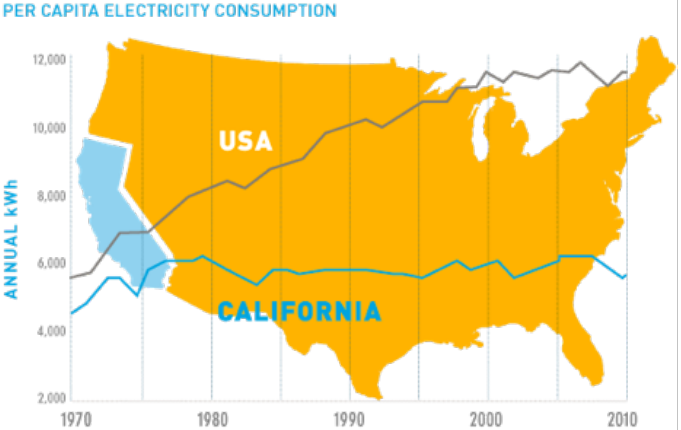
Figure 4. The Rosenfeld effect. California’s aggressive energy policy led by Energy Commissioner Art Rosenfeld has kept per capita electricity consumption flat for decades [17].